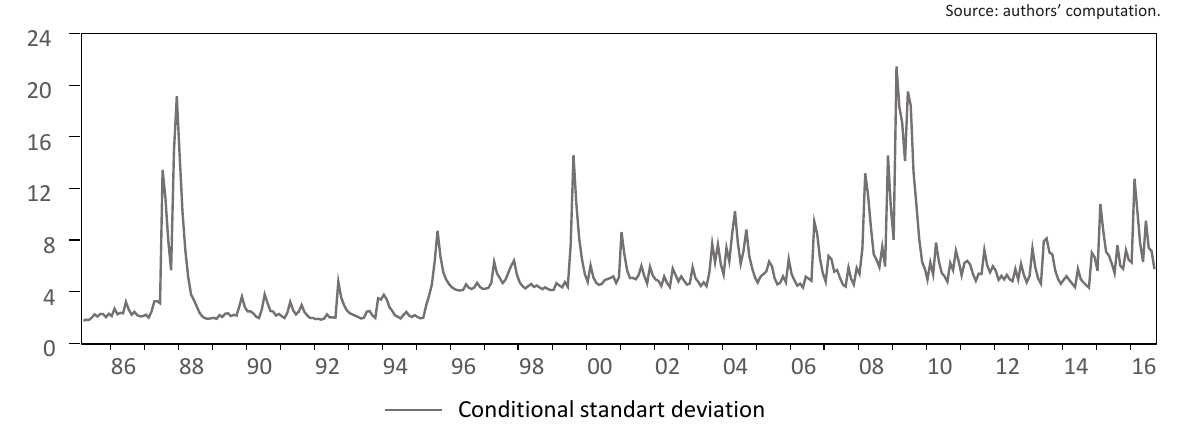
Figure 4. Conditional standard deviation